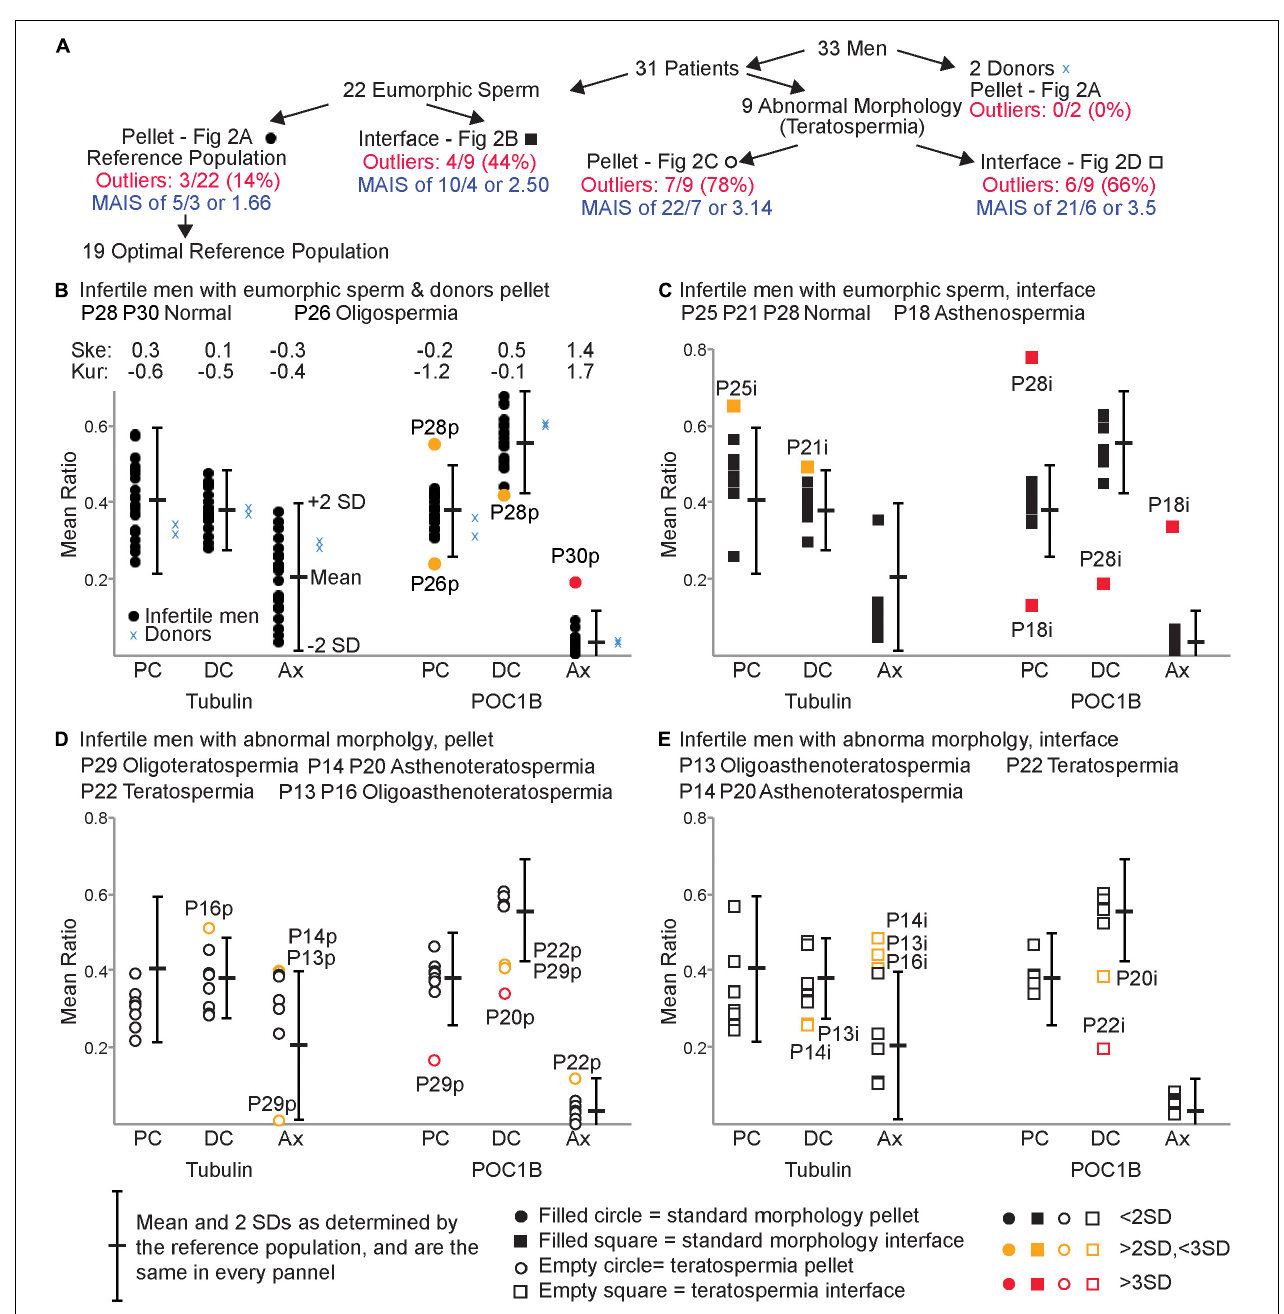
FIGURE 2 | FRAC can identify sperm populations with suboptimal centrioles. (A) Breakdown of the 5 populations used. (B–E) For each panel, the mean and two standard deviations (SD) of the reference population are indicated to the right of each set of mean ratios. (B) Mean ratios of the pellet eumorphic sperm (the reference population) and pellet sperm from donors. The top of the graph indicates the skewness (Ske) and kurtosis (Kur) of the mean ratios of the optimal reference population. (C) Mean ratios of the interface eumorphic sperm. (D) Mean ratios of the pellet sperm with teratospermia. (E) Mean ratios of the interface sperm with teratospermia. Samples that were outside of 2 SD were identified as outliers (colored yellow and labeled). Outliers that were beyond 3 SD are colored red and labeled. The semen analysis results of these outlier patients are identified in the upper left of each graph. MAIS, mean affected individual score.